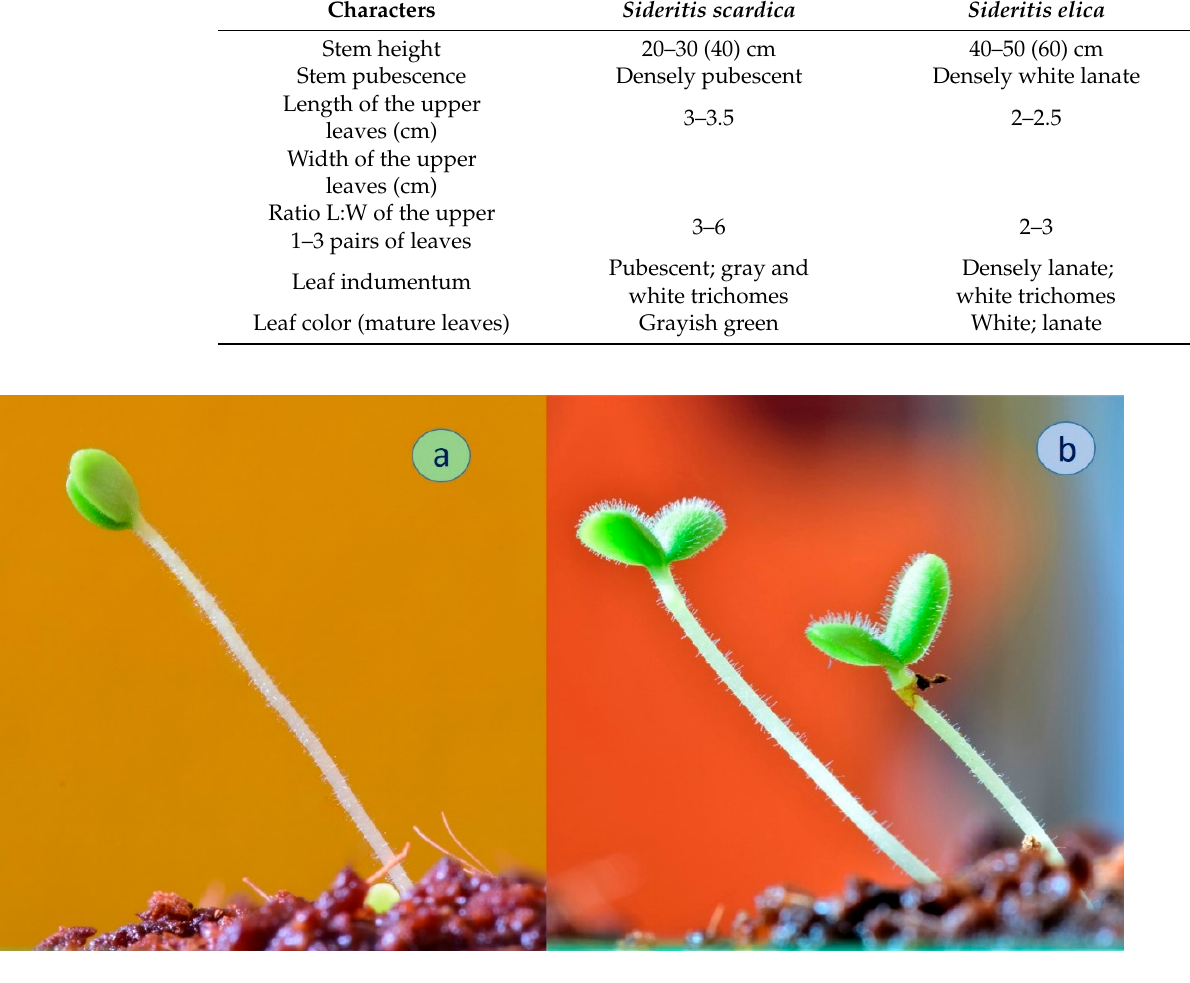
Figure 4. Juvenile plants of: ( a ) Sideritis scardica and ( b ) Sideritis